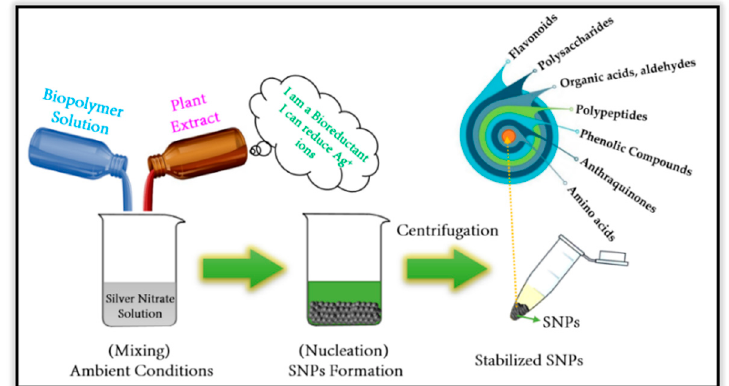
Figure 1. Phyto-synthesis and stability of silver nanoparticles (SNPs) in combination with biopolymers.